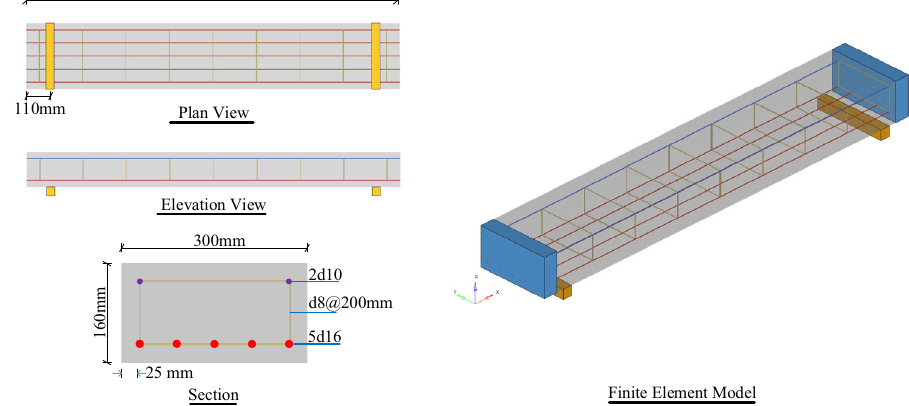
Fig. 3 Configuration and reinforcement details of B40 beam.